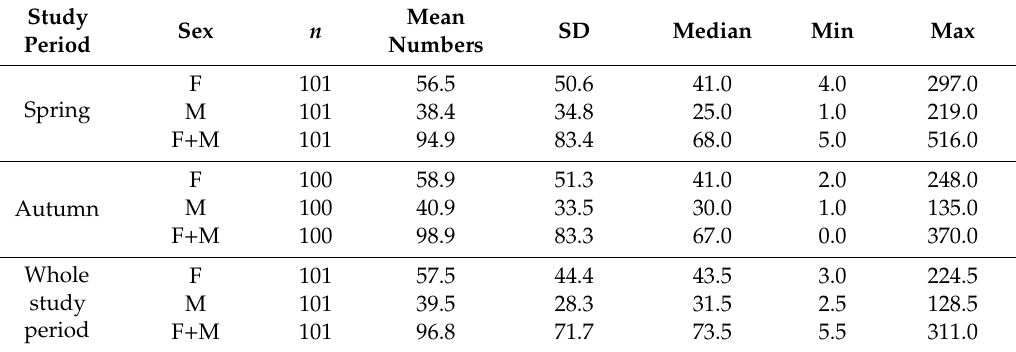
Table 2. Mean density of D. reticulatus ticks per 100 m 2 in Lublin